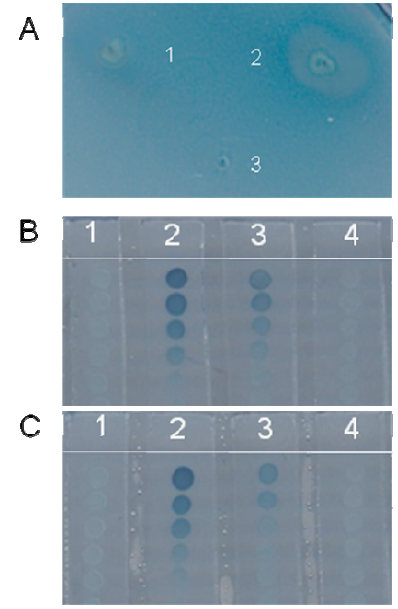
Figure 1. Isolation of bacteria expressing anti-LasR QS system activity. ( A ) Agar plate screening assay; the diffuse and lightly colored areas surrounding the strain indicate inhibition of OdDHL production. Strain 2 caused a strong degree of inhibition, but did not affect the growth of NT1. Strains 1 and 3 showed no inhibitory activity; ( B ) Inhibition of OdDHL production in a secondary screen. 1: methanol as a negative control; 2: OdDHL 100 nM; 3: OdDHL 100 nM plus extract from JM2, the extract from JM2 showed strong inhibitory activity; 4: extract from JM2 showed no autoinducer activity; ( C ) Inhibition of OdDHL production for the JM2 partially purified extract F5. 1: methanol as a negative control; 2: OdDHL 100 nM; 3: OdDHL 100 nM and F5, F5 showed stronger inhibitory activity than the crude extract; 4: extract from JM2 showed no autoinducer